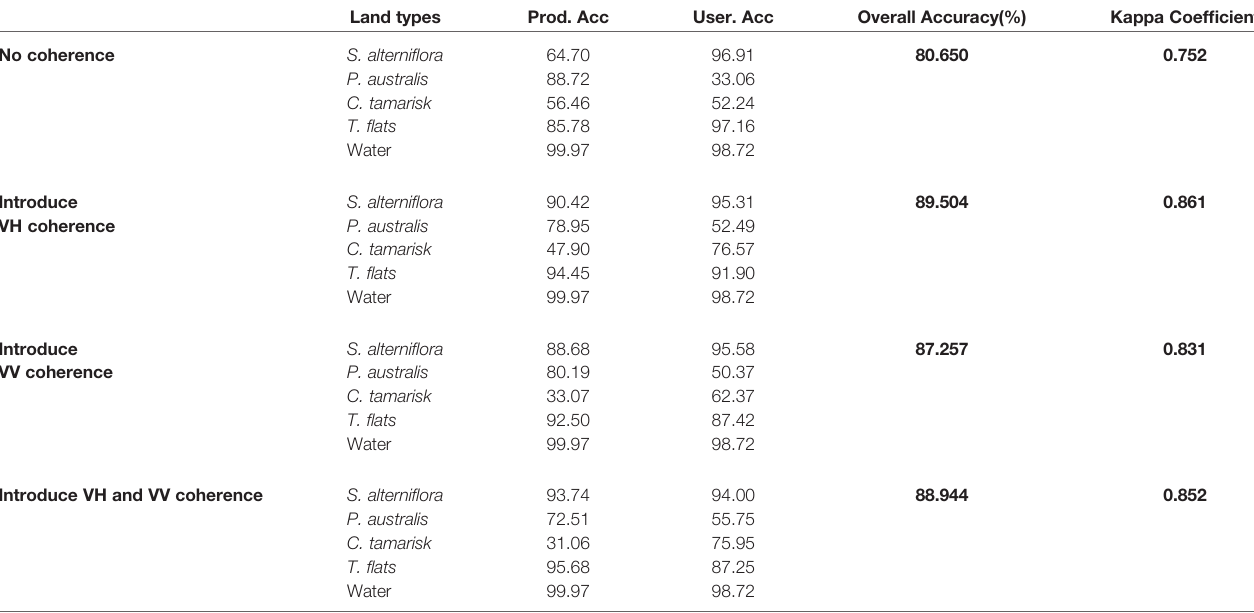
TABLE 3 | The classi fi cation accuracies with combining different polarization